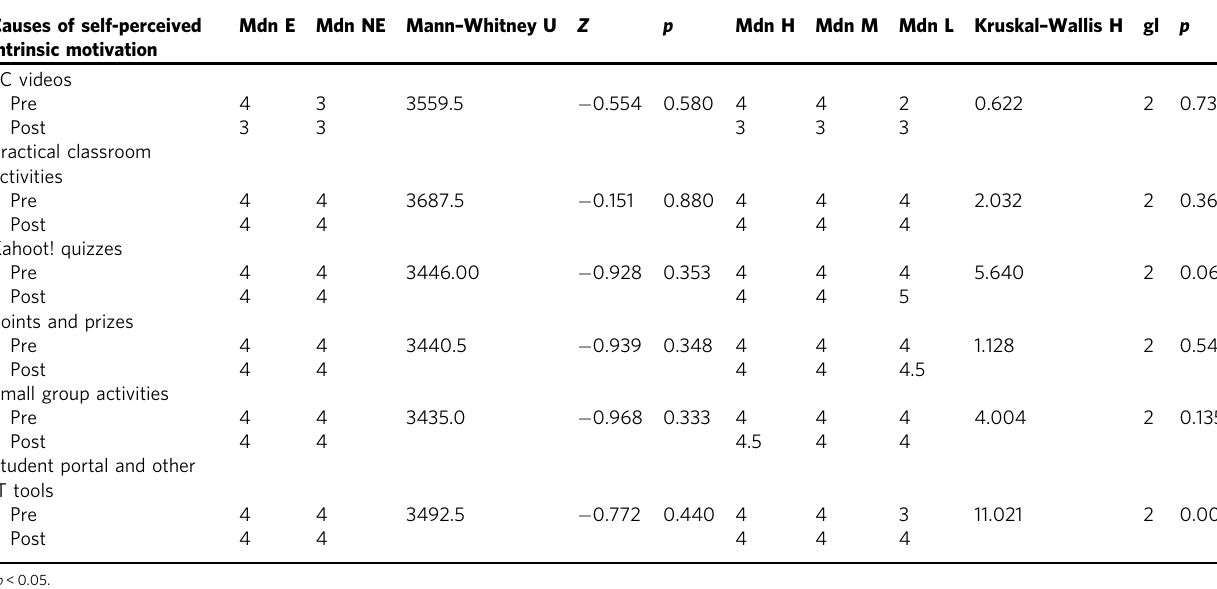
Table 4 Non-parametric results for the variables referring to the evaluation of the strategies used to foster students ’ motivation in this approach during the COVID-19 pandemic.